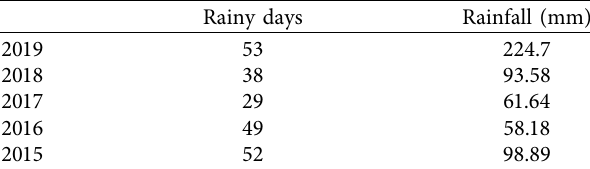
Table 1: Rainfall amount from 2015 to 2019 in